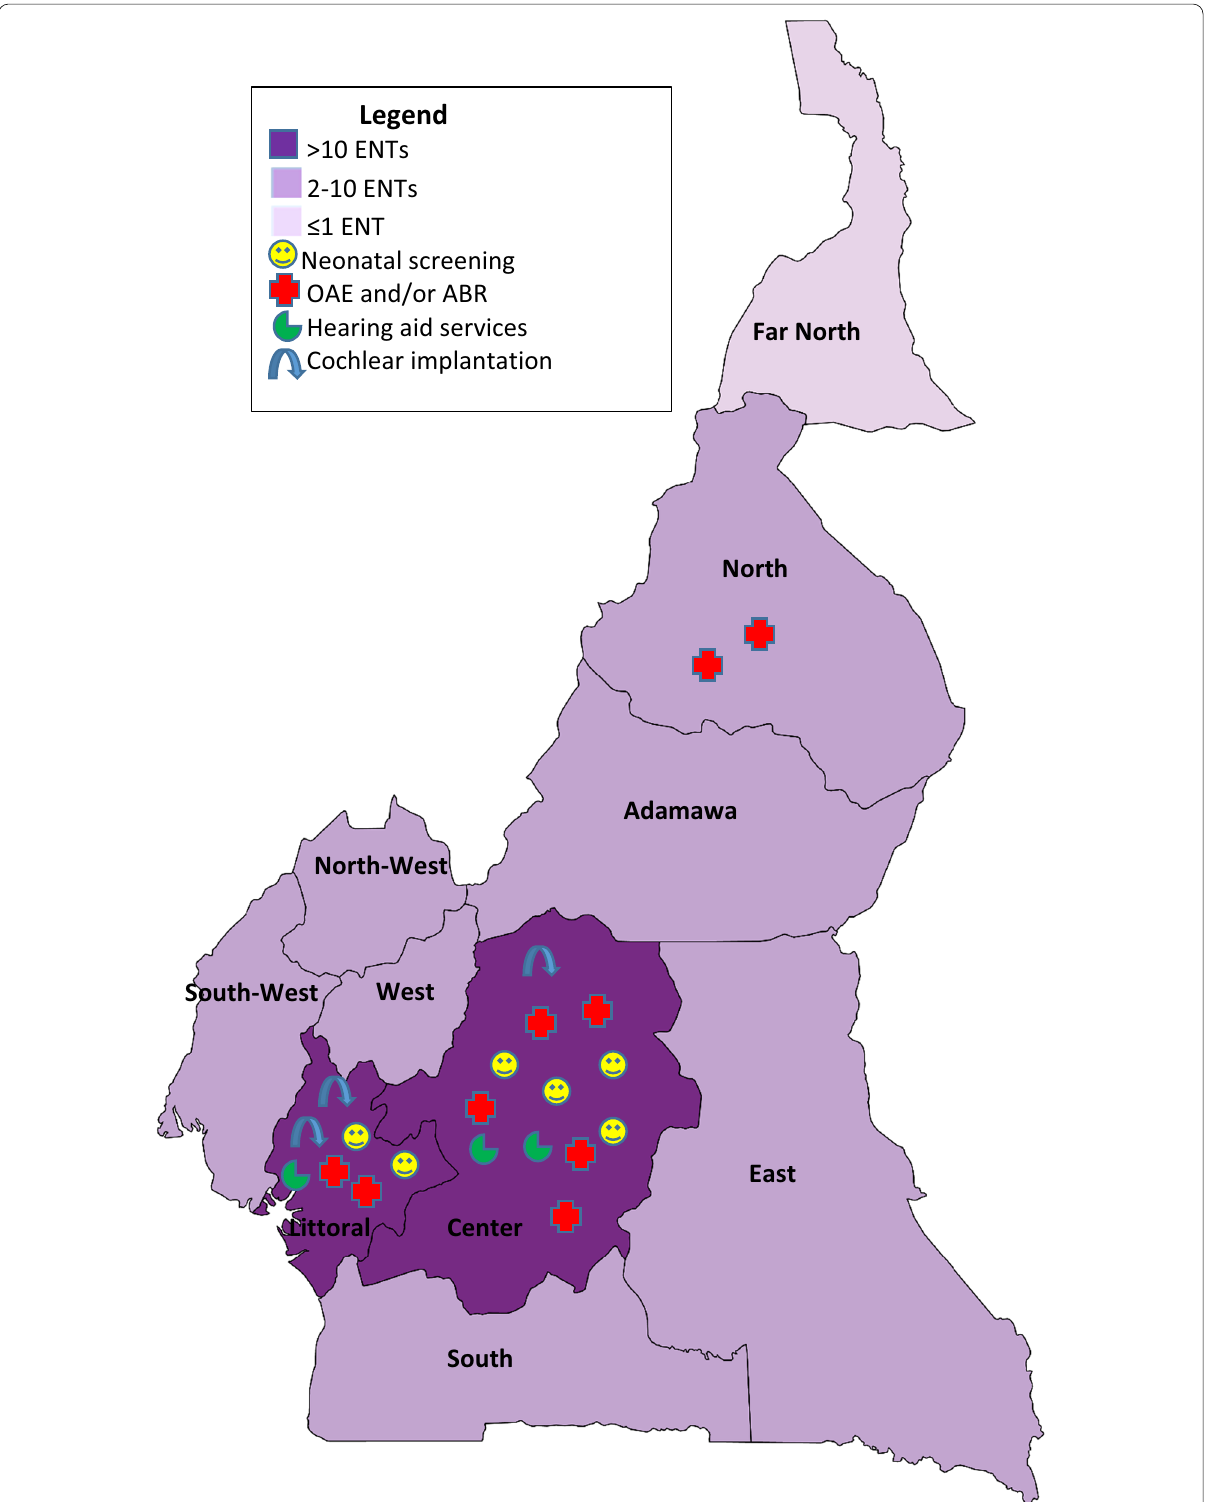
Fig. 1 Distribution of specialists and hospitals offering diagnosis and treatment for congenital hearing loss in Cameroon. ABR auditory‑evoked brainstem response, ENT ear–nose–throat specialist, OAE otoacoustic